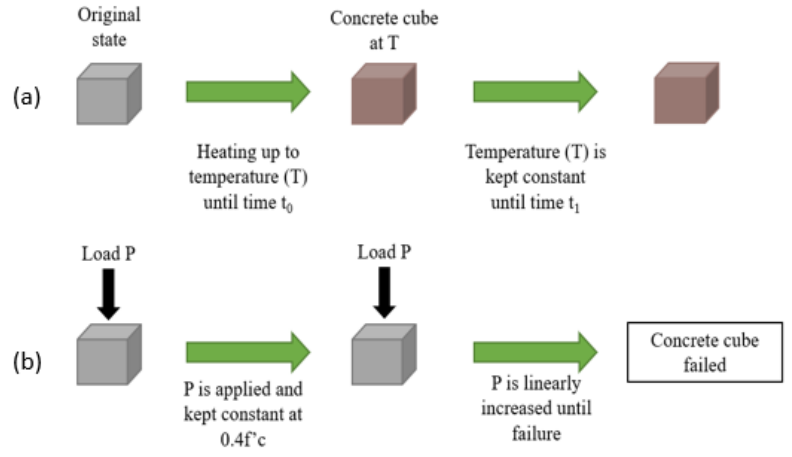
Figure 1. ( a ) Heating and ( b ) loading schemes of the stressed condition.